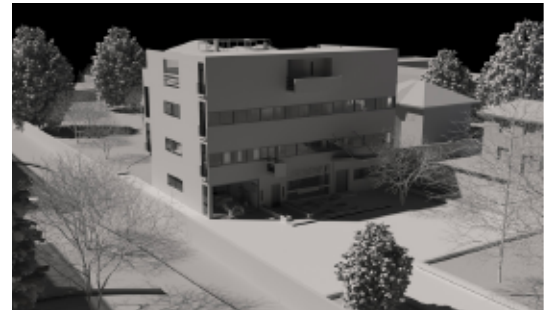
Figure 15. View of the